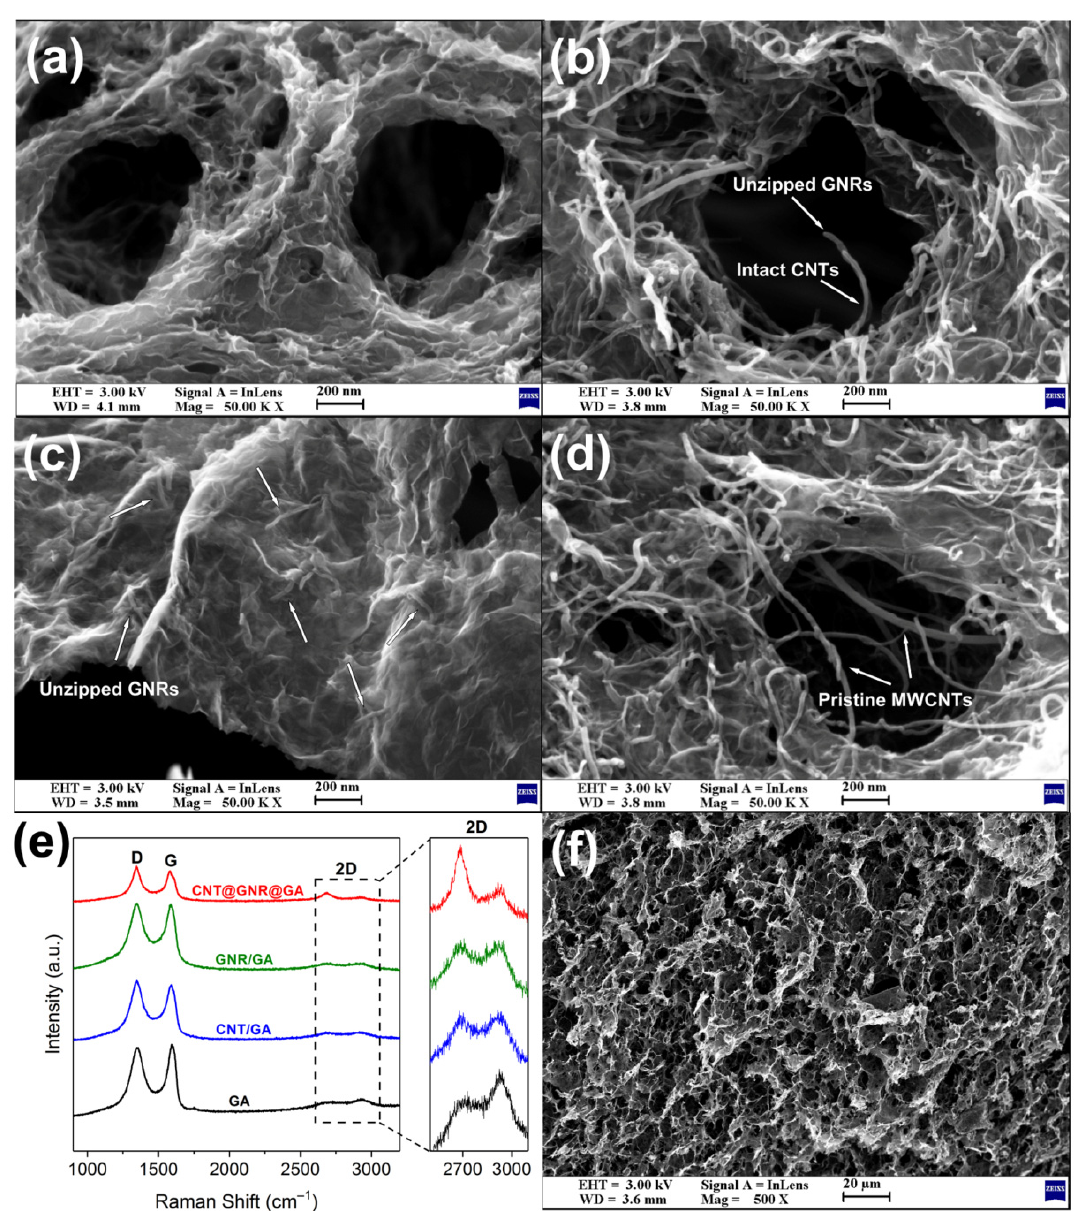
Figure 3. SEM images of ( a ) GA, ( b ) CNT@GNR@GA, ( c ) GNR/GA, and ( d ) CNT/GA. ( e ) Raman spectra of the resulting aerogels; ( f ) cross-sectional SEM image of CNT@GNR@GA.